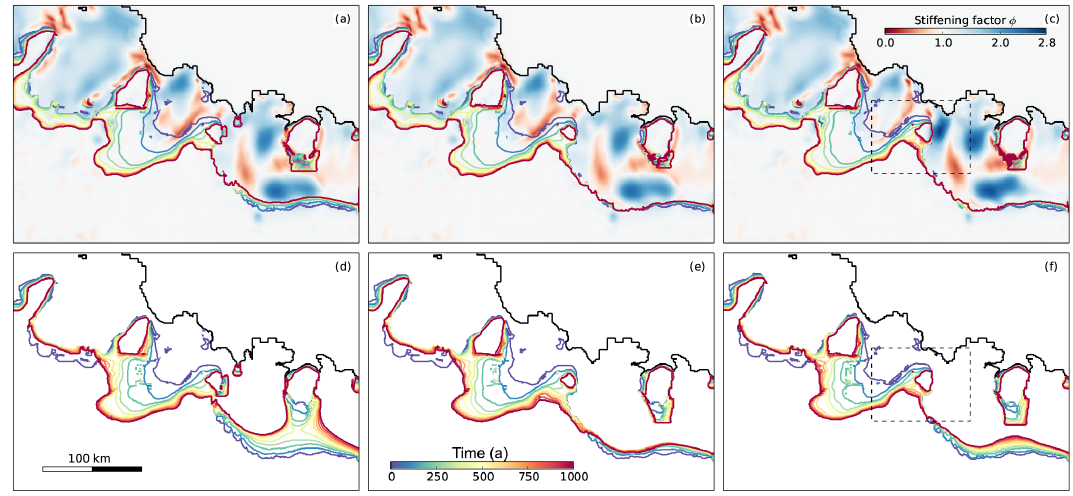
Figure 7. Grounding-line migration for medium melt rates and linear sliding. Melt rates M b1 (a–c) and M b2 (d–f) . Experi- ments B e /S/L/M b1 /A m (a) , B e /U/L/M b1 /A m (b) , RF/S/L/M b1 /A m (c) , B e /S/L/M b2 /A m (d) , B e /U/L/M b2 /A m (e) , and RF/S/L/M b2 /A m (f) . Grounding lines are shown every 100 years. In (a–c) the stiffening factor field is shown in the background, and a dashed line window is drawn to point out the area where excessive stiffening occurs when omitting PPw in data assimilation.